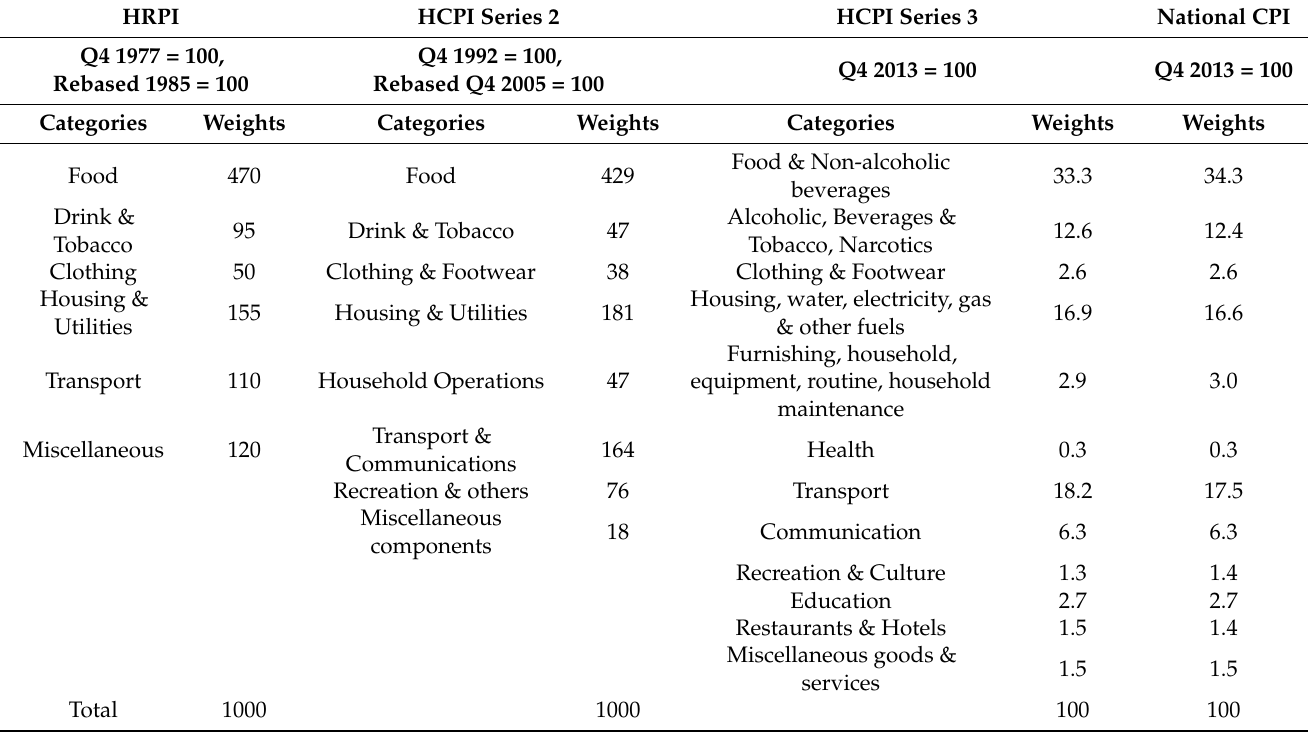
Table 2. Evolution of Solomon Islands CPI